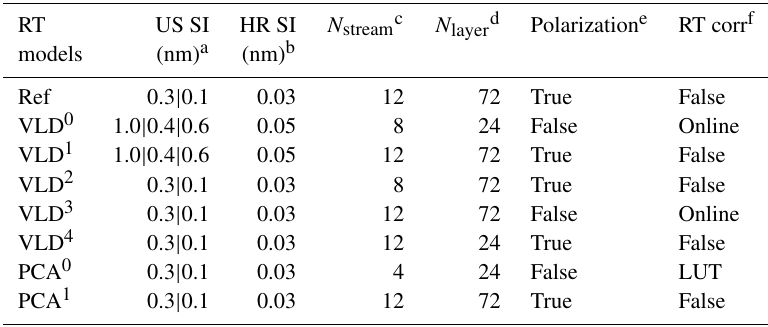
Table 4. List of configurations used in evaluating the different forward model calculations for OMI ozone profile retrievals. The reference, VLIDORT, and PCA-RT models are abbreviated as Ref, VLD, and PCA, respectively.